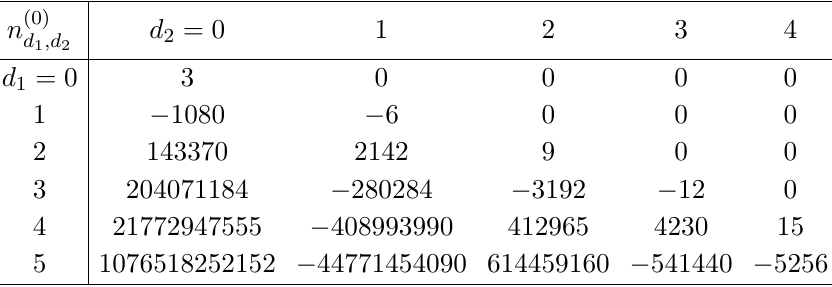
Table 17 . Base degree one Gopakumar-Vafa invariants at low genera for X (1)